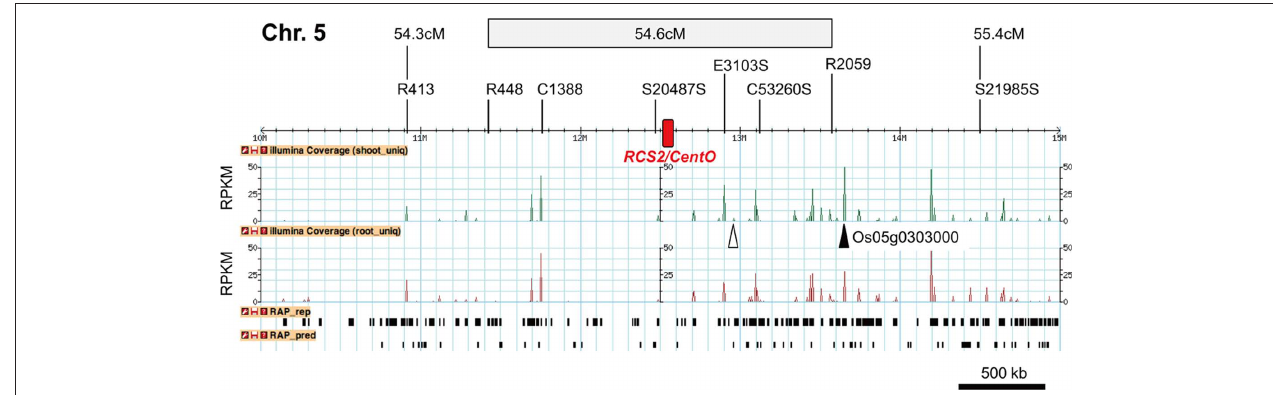
shown as 50). The level of expression is normalized to that of the shoot (standard). Gene models based on Rice Annotation Project (RAP) representative loci (RAP_rep) and RAP predicted genes (RAP_pred) are shown. Expression of an RAP predicted gene is shown (white triangle). The position of Os05g0303000 , a homolog of the wheat PSR161 gene mapped on wheat Cen1B (see text), is also indicated (black triangle). Red boxes represent RCS2 / CentO